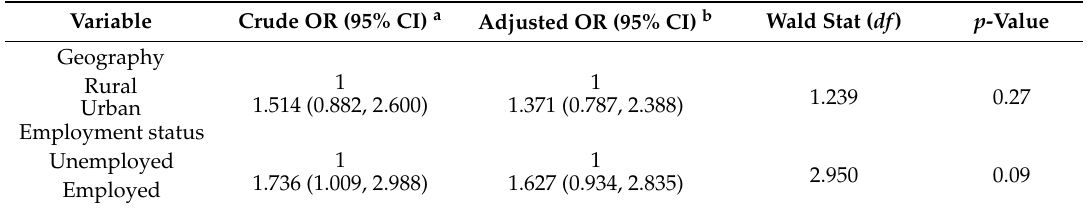
Table 6. Associated factors for satisfactory practice toward leptospirosis using multiple logistic regression ( N =